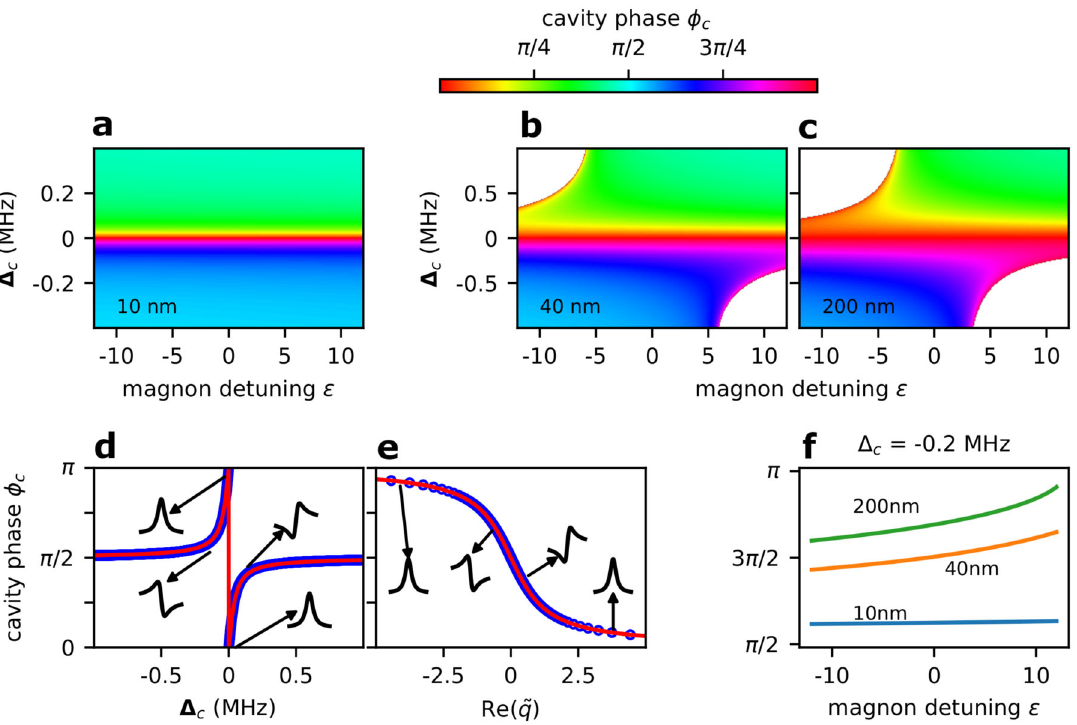
Fig. 3 The Fano interference picture. The cavity background channel phase φ c as calculated from Eq. (7) with the experimentally determined parameters is shown in dependence on the cavity and magnon detunings for the case of ( a ) 10 nm, ( b ) 40 nm, and ( c ) 200 nm thick permalloy fi lm inserted into the cavity. The white regions in ( b ) and ( c ) correspond to regions in which η becomes imaginary. d , e The cavity phase for the 10 nm fi lm at zero dimensionless magnon detuning as a function of cavity detuning and Re ð ~ q Þ , respectively. The blue open dots represent the cavity phase calculated on the basis of fi ts of the fi xed frequency lineshapes, whereas the red lines represent the cavity phase of the theoretical Fano interference picture with η ¼ 1 . f The cavity phase at cavity detuning Δ c = − 0.2 MHz for the three thicknesses investigated. Note tha t only for the case t = 10 nm the cavity phase is essentially constant as a function of magnon